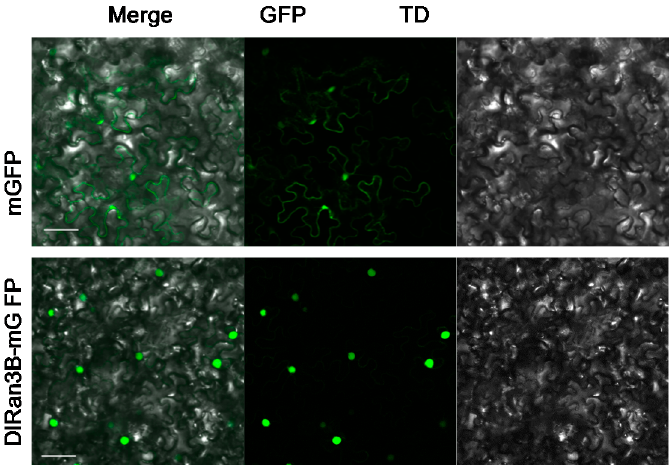
Figure 1. Subcellular localization of DlRan3B. Transient expression of a fluorescent fusion protein (DlRan3B-mGFP (green fluorescent protein)) by agro-infiltration in epidermal cells of tobacco ( Nicotiana benthamiana ) leaves; the upper image (mGFP) is green fluorescence of pCAMBIA1302-GFP and the lower one (DlRan3B-mGFP) is green fluorescence of DlRan3B-mGFP; TD refers to the transmitted light channel. Bars = 50 μ m.